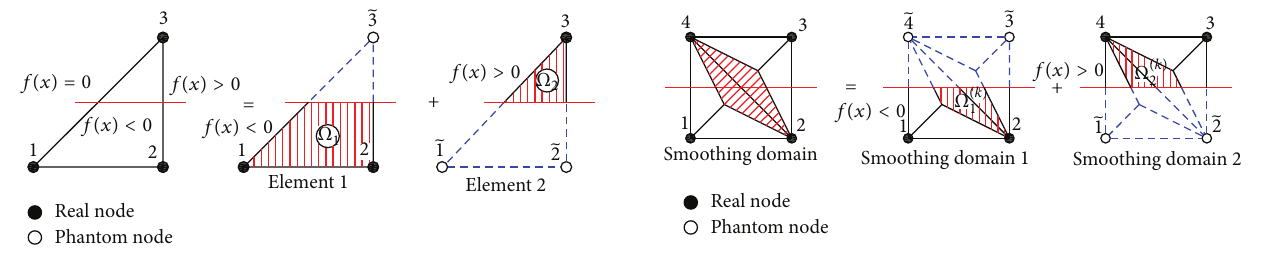
Figure 2: The decomposition of a cracked element into two super- imposed elements.